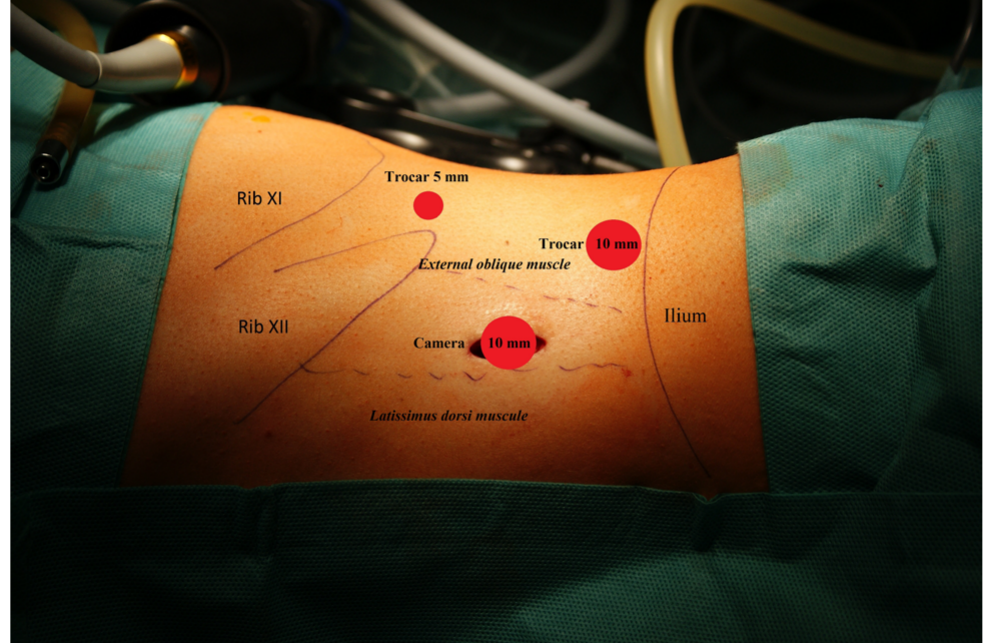
Figure 1 - Scheme of patient's position with marked trocar sites. Patient placed in the left flank position during removal of the right